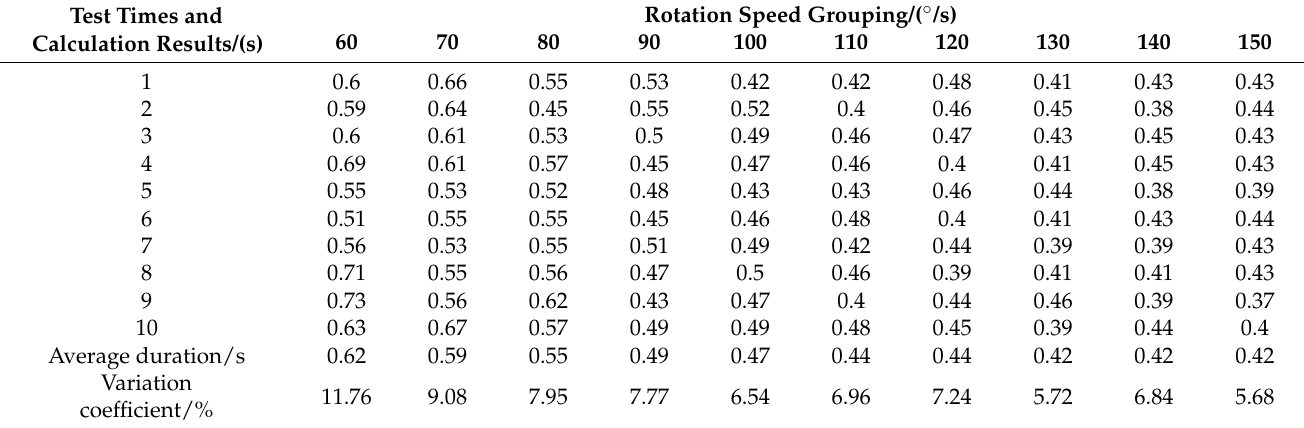
Table 3. Test results of seedling uniformity under multiple planting